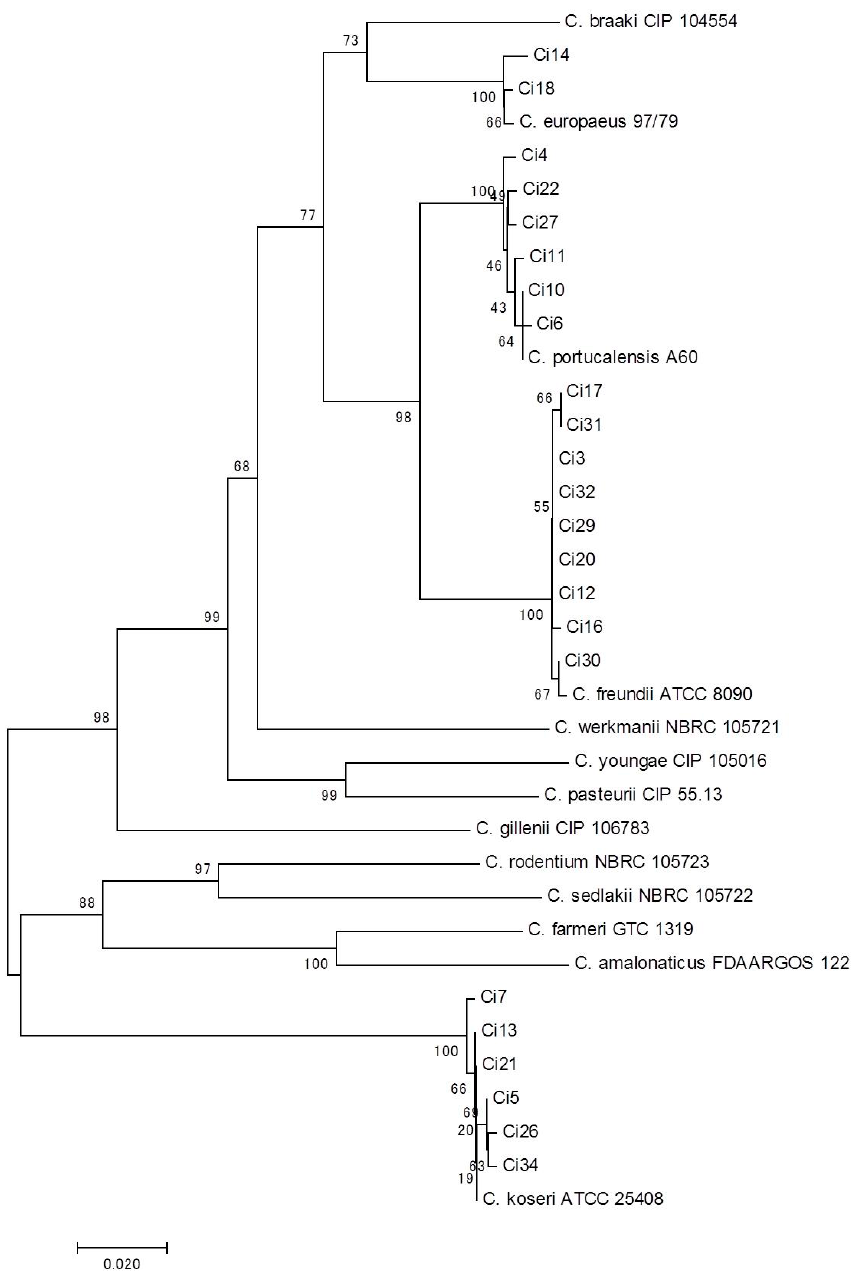
Figure 1. Neighbor-joining tree based on recN gene sequences from our data collection and type strains of Citrobacter species. Genetic distances were constructed using Kimura’s two-parameter method. Bootstrap values obtained after 1000 replicates are given at the nodes [11]. The corresponding GenBank/Patric accession numbers of type strains refer to the previous report by Ribeiro et al. [6].